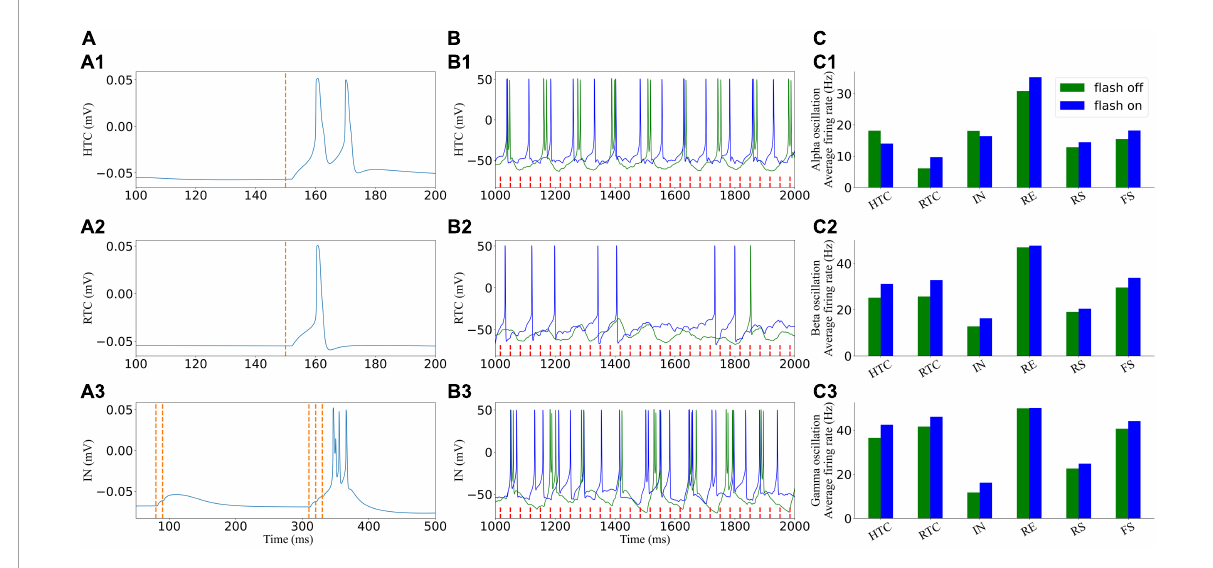
FIGURE4 Effects of light (40 Hz) flicker on the TC network signal cells. (A) Single cells respond to incoming GC spikes: (A1–A3) HTC, RTC, and IN, respectively. (B) Voltage traces of two representative cells in the TC network before (green) and under (blue) light (40 Hz) flicker stimulation. (C) Average firing rate when the flicker was on and off: (C1–C3) alpha, beta, and gamma oscillatory states, respectively. The red dotted line represents incoming GC